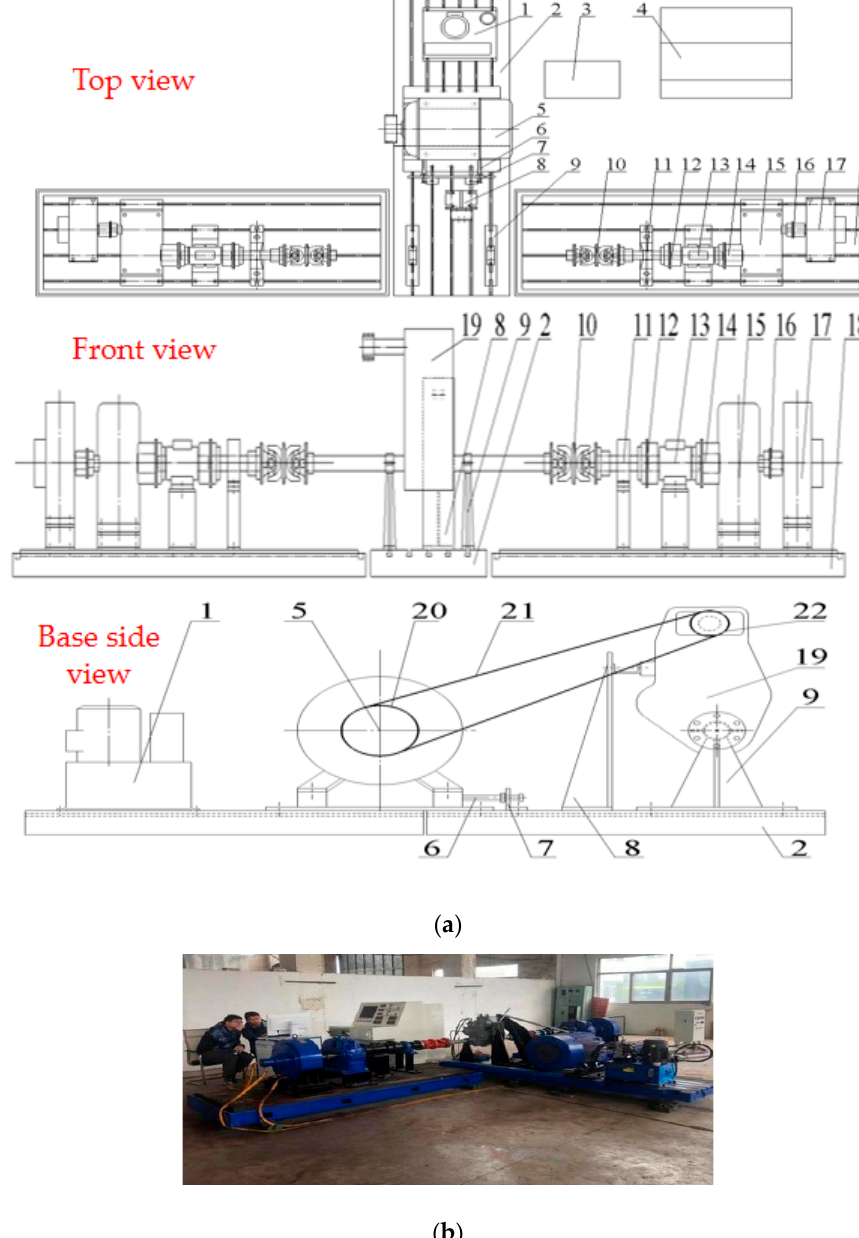
Figure 5. Gearbox assembly test bench structural schematic diagram ( a ) and physical diagram ( b ). 1. hydraulic station, 2. longitudinal installation base, 3. main power cabinet, 4. central control cabinet, 5. drive motor, 6. positioning bolt, 7. positioning support, 8. gearbox installation support, 9. gearbox fixed support, 10. universal coupling, 11. sliding bearing, 12. double coupling A, 13. torque speed sensor, 14. coupling B, 15. reduction box, 16. coupling C, 17. magnetic powder brake 18. transverse mounting support, 19. gearbox under test, 20. large pulley 21. five-slot B belt, 22. small pulley.